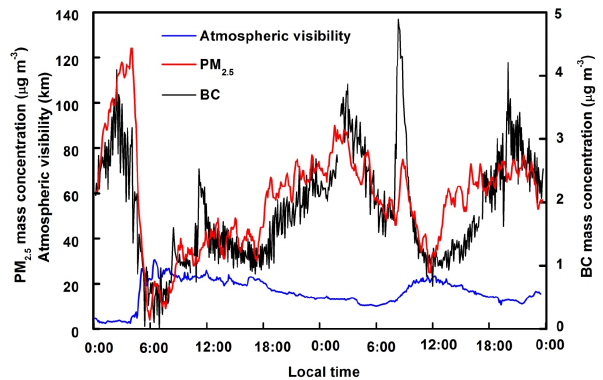
Figure 6. Temporal evolutions of 5min mean atmospheric visibil- ity, BC and PM 2 . 5 concentrations during the new particle formation event on 3 and 4 April 2012.